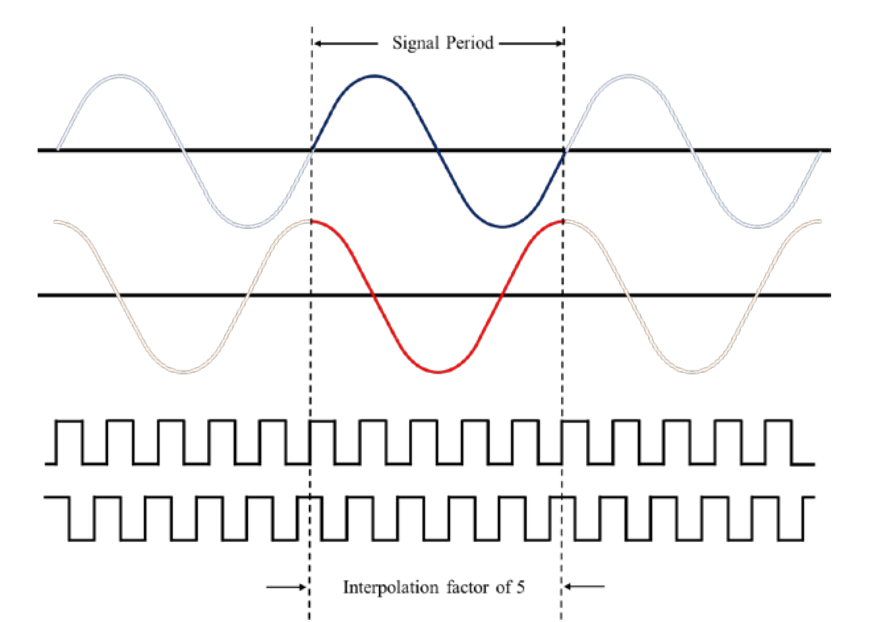
Figure 1. Block diagram of the interpolation module.